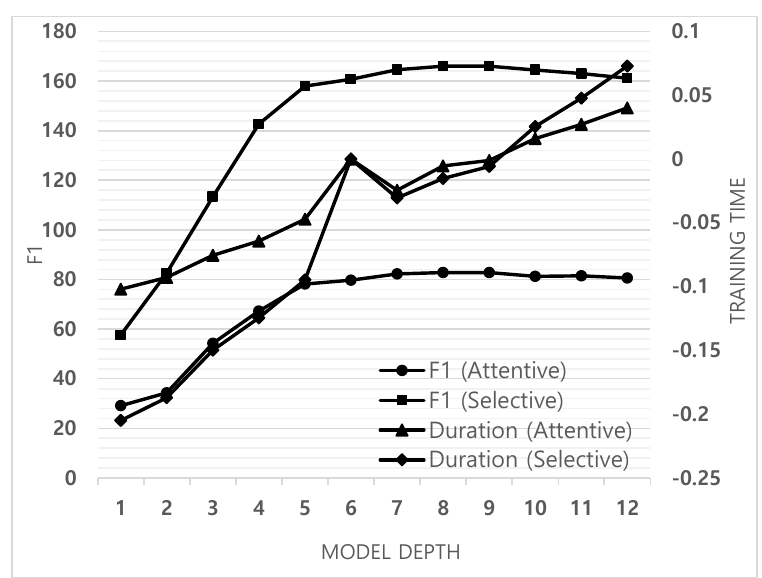
Figure 5. Performance changes with respect to model depth.